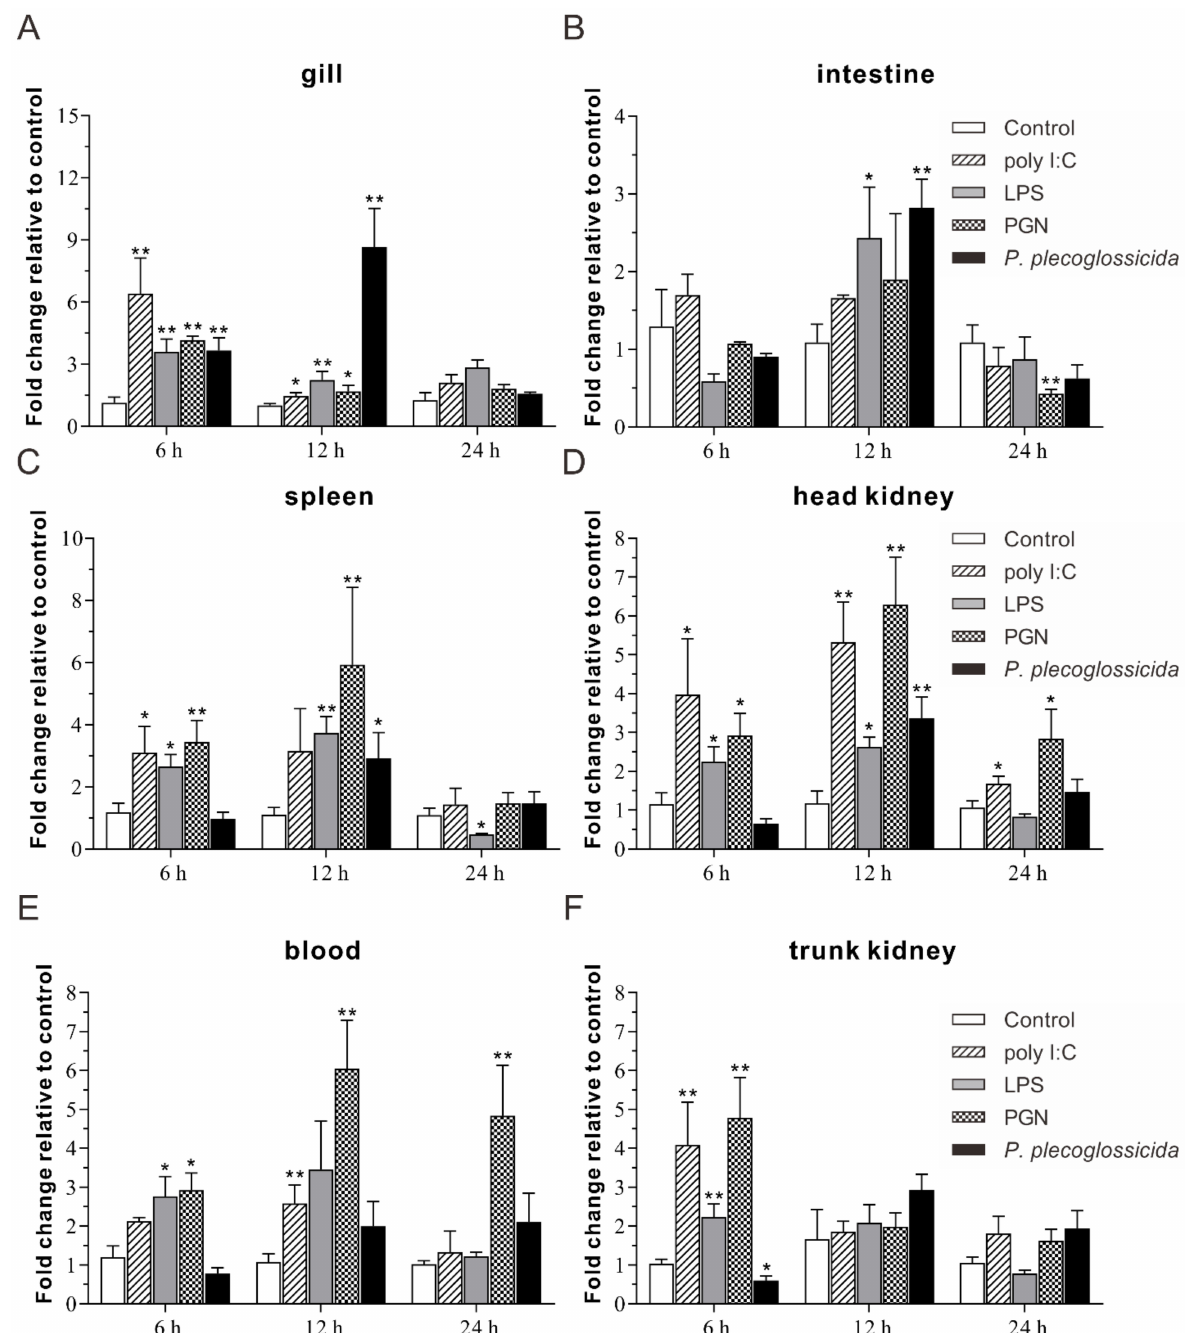
Figure 6. Expression patterns of Lc-RIP3 in response to stimulations of poly I:C, LPS, PGN, and P. plecoglossicida . A healthy large yellow croaker (five groups) was injected intraperitoneally with 100 µ L of PBS (control), poly I:C (1 mg/mL), LPS (0.5 mg/mL), PGN (1 mg/mL), or a P. plecoglossicida suspension in PBS (5 × 10 5 CFU/mL), respectively. The mRNA expression levels of Lc-RIP3 in the gill ( A ), intestine ( B ), spleen ( C ), head kidney ( D ), blood ( E ), and trunk kidney ( F ) were examined by qRT-PCR at indicated time points post-stimulation with the results calculated by the normalization to the expression of β -actin and then recorded as a fold change compared with the control group at the same time point. All of the data are shown as mean ± SE ( n = 6) with bars representing the SE. * p < 0.05, ** p <